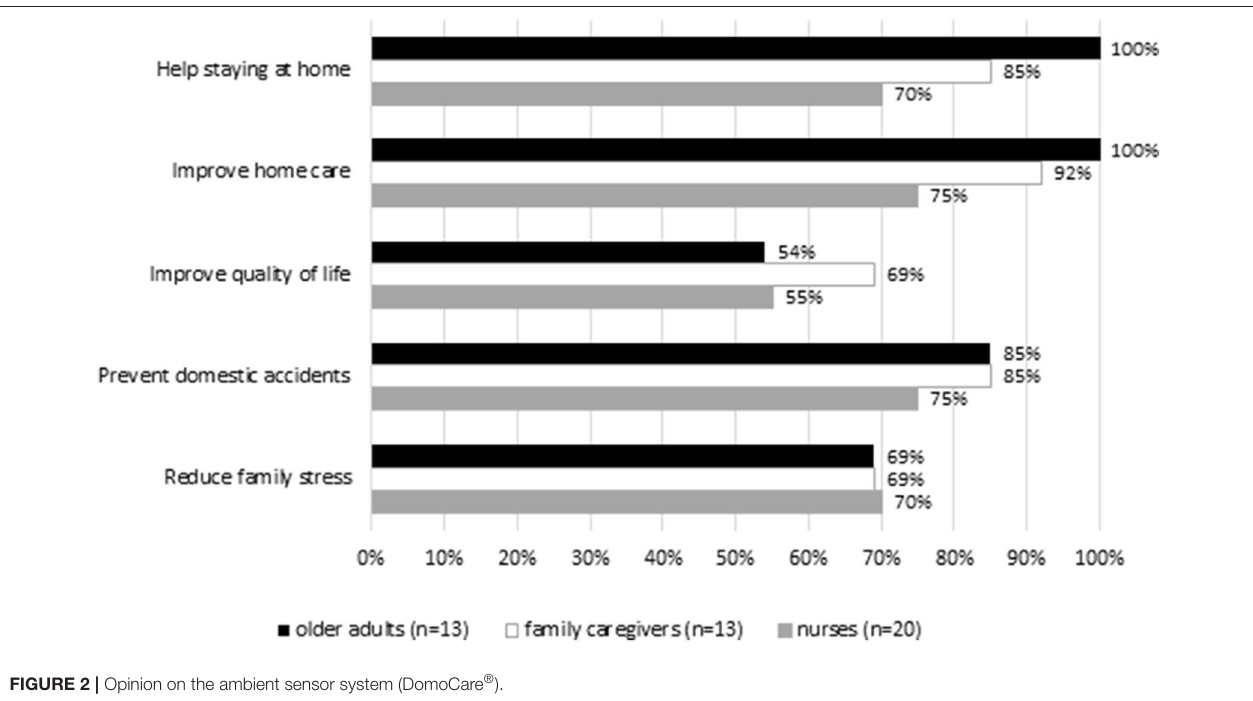
FIGURE 2 | Opinion on the ambient sensor system (DomoCare ® ).